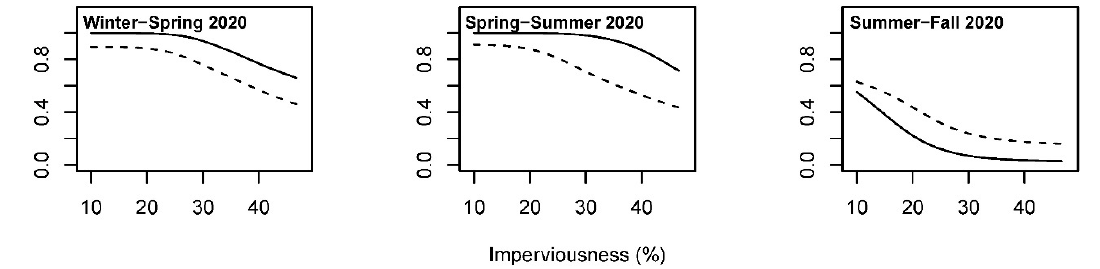
Figure 4. Mean back-transformed predictions of colonization (dashed lines) and survival probability (solid lines) ( y -axis) of juvenile blue crabs Callinectes sapidus in North Carolina (USA) tidal creeks as a function of percent watershed imperviousness ( x -axis). Colonization and survival were predicted for the interval between successive seasons from fitting a dynamic occupancy model to presence/absence data. Predictions were made across the range of imperviousness values for the watersheds of tidal creeks sampled in this study. The single legend (in the first panel) applies to all graph panels.